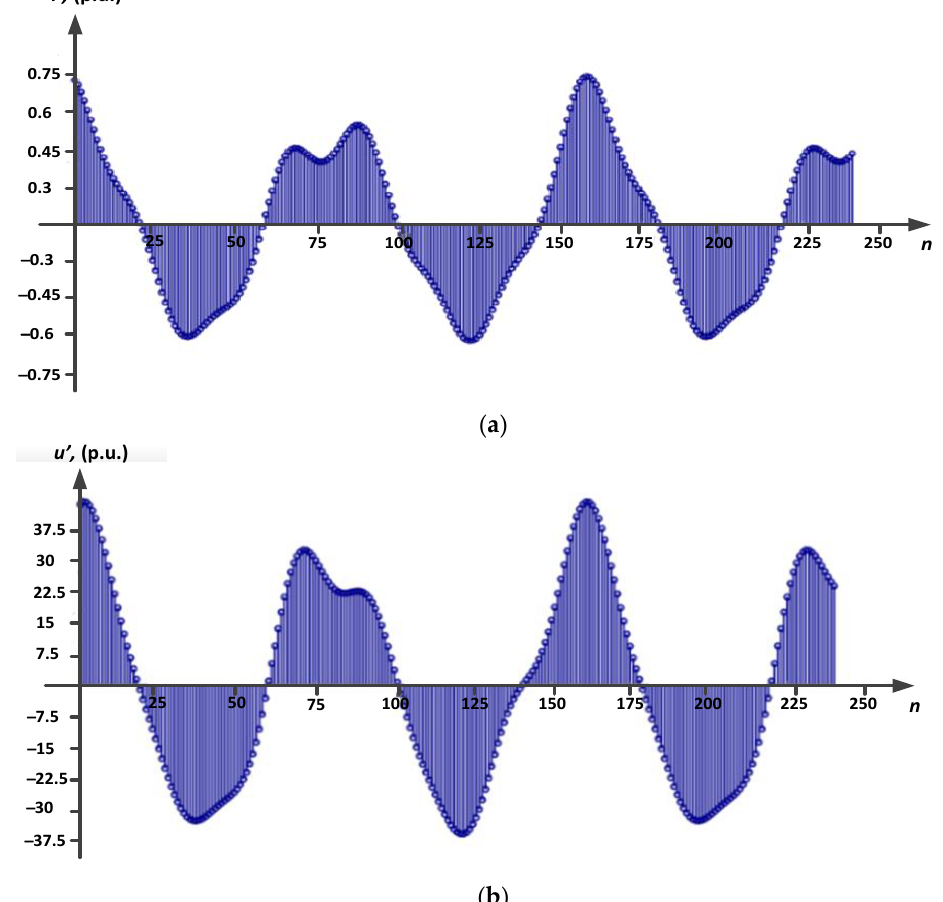
Figure 2. Sinusoidal signals distorted by interharmonics: ( a ) current; ( b ) voltage.